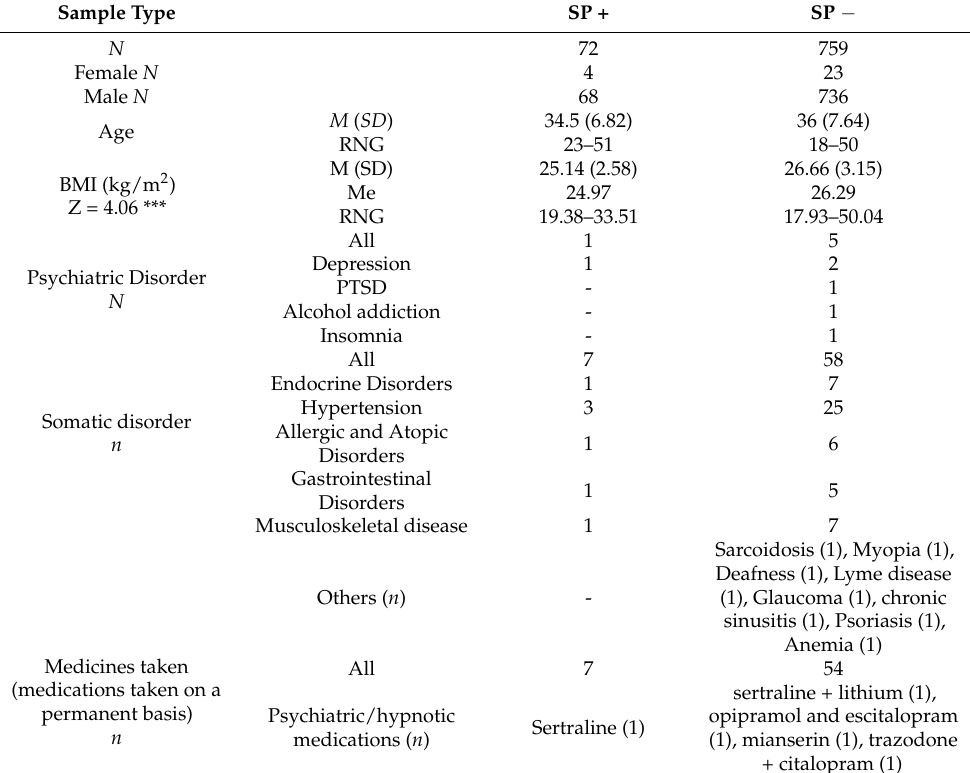
Table 1. Participants’ demographic and health status